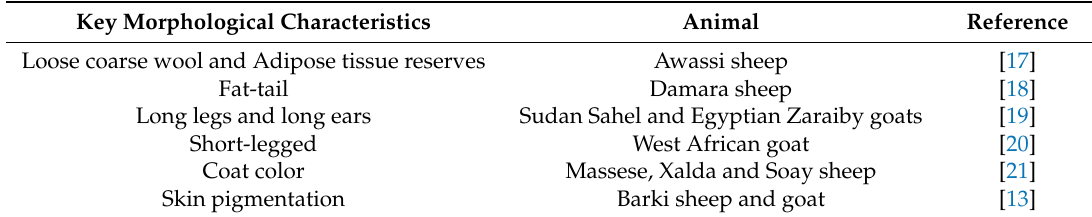
Table 1. The key morphological adaptations in sheep and goat. Key Morphological